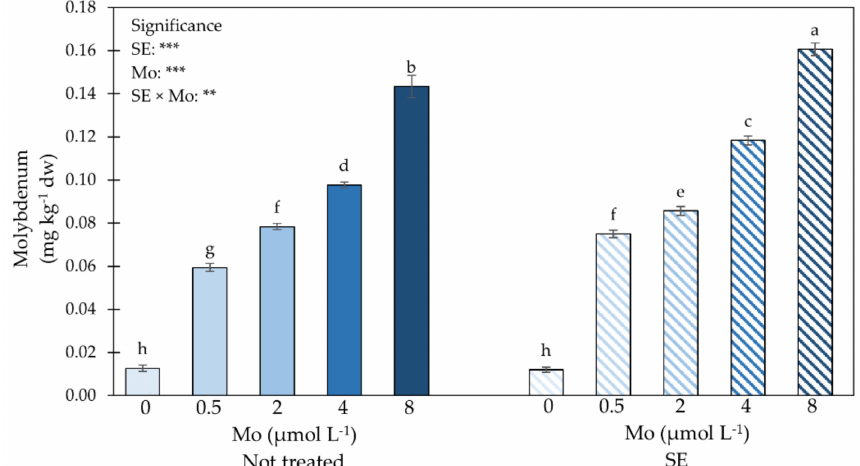
Figure 3. Impact of SE application and Mo-biofortification on molybdenum concentration in leaves of spinach plants cultivated in a protected environment. Values with diverse letters significantly differ at p ≤ 0.05. **, *** significant at 0.005 or 0.001, respectively. Bars indicate mean ± standard error of 3 replicates of 5 samples.